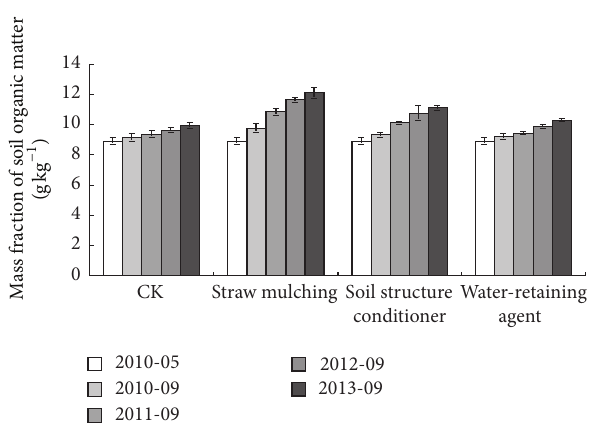
Figure 4: Changes of organic matter content in plough layer with different regulatory